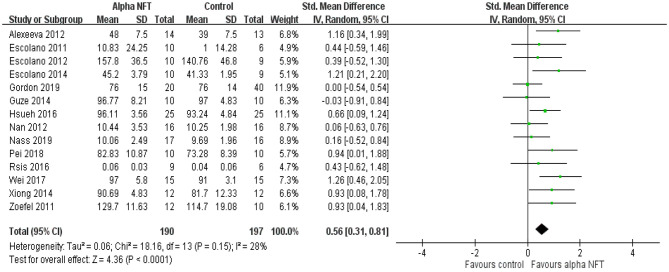
Forest plots for meta-analysis of alpha NFT on working memory in healthy participants. SD, standard deviation; Std, standardized.